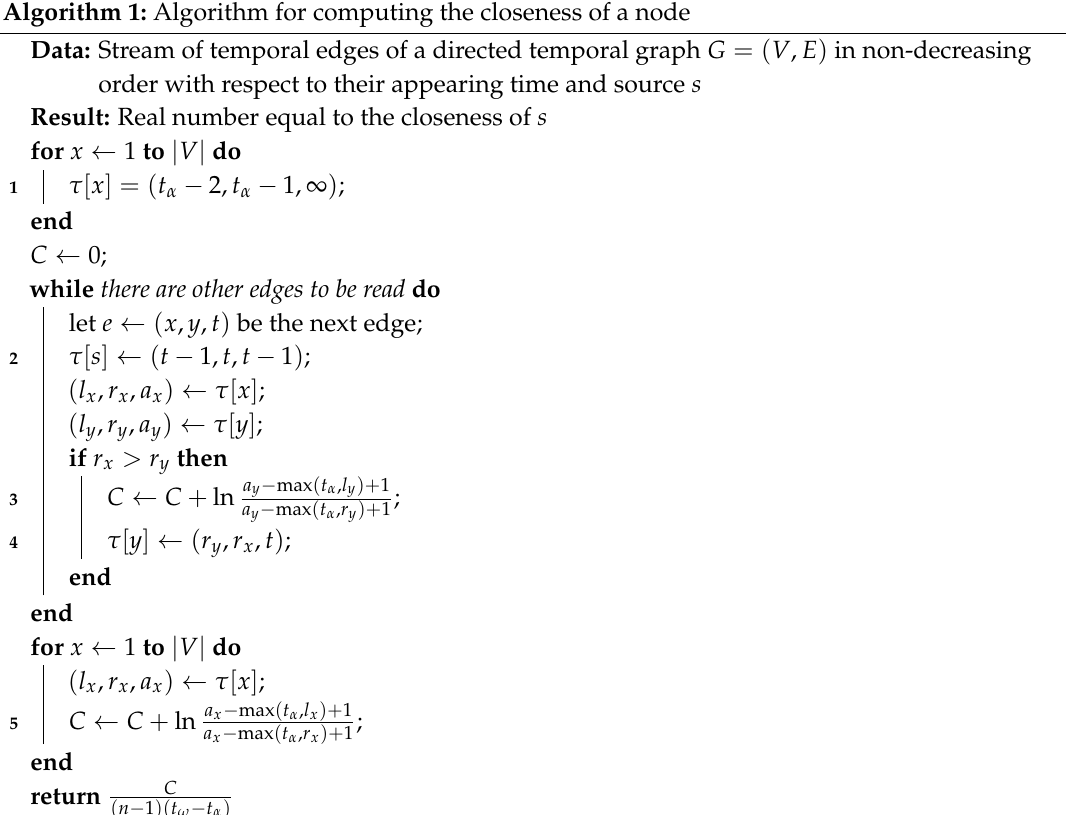
Algorithm 1: Algorithm for computing the closeness of a node Data: Stream of temporal edges of a directed temporal graph G = ( V , E ) in non-decreasing order with respect to their appearing time and source